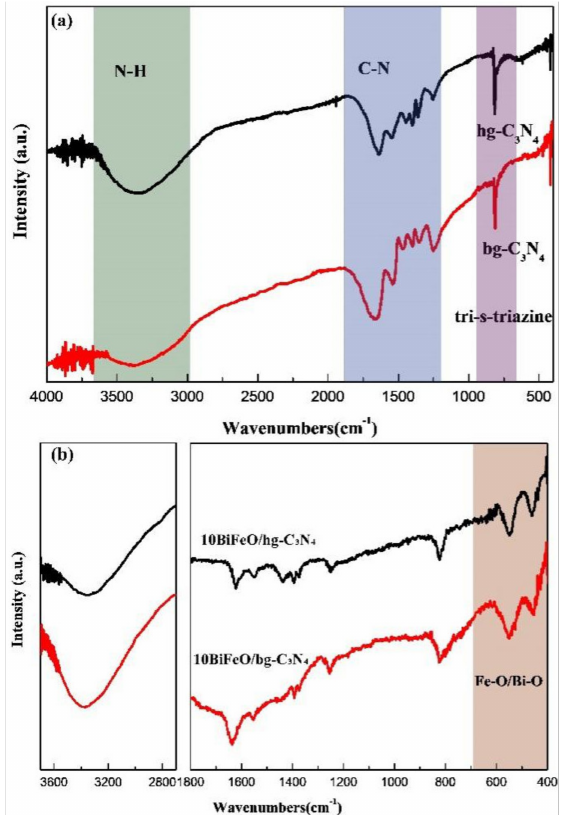
Figure 2. FT-IR transmission spectra of ( a ) hg-C 3 N 4 and bg-C 3 N 4 ; ( b ) 10BiFeO/hg-C 3 N 4 , and 10BiFeO/bg-C 3 N 4